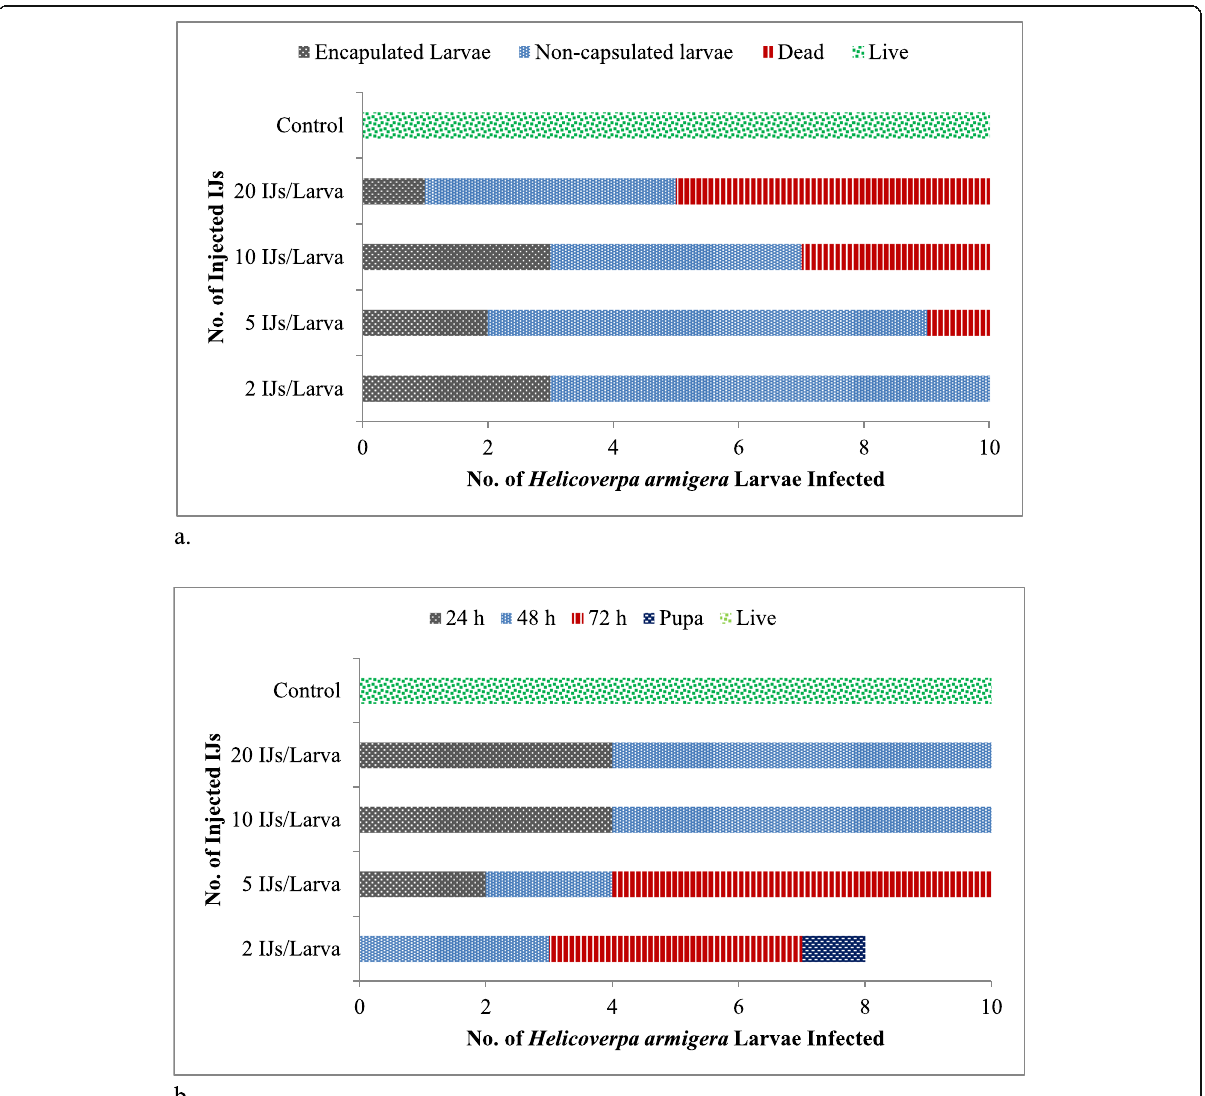
Fig. 4 Encapsulation responses of Helicoverpa armigera infected with Steinernema abbasi - Xenorhabdus indica complex. a First batch of larvae dissected for encapsulation. b Second batch of larvae showing rate of